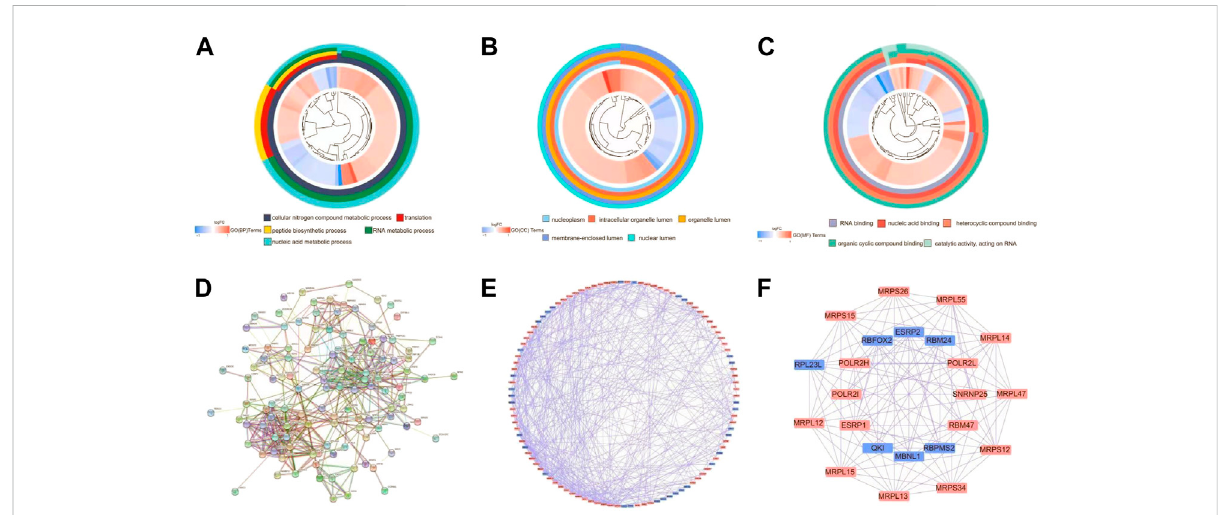
FIGURE 3 Functional enrichment analyses for differently expressed genes and Protein-protein interaction (PPI) network construction and modules analysis. (A) Circos plot showing enriched GO-BP (Gene Ontology-Biological Process) terms of differently expressed RBPs. (B) Circos plot showing enriched GO-CC (Gene Ontology-Cellular Component) terms of differently expressed RBPs. (C) Circos plot showing enriched GO-MF (Gene Ontology-Molecular Function) terms of differently expressed RBPs. (D) PPI interaction network map obtained from STRING website. (E) Cytoscape visualizes the genes of the interacting PPI network. Red nodes represent up regulated genes, while blue nodes refer to down regulated genes. (F) The most signi fi cant MCODE components form the PPI